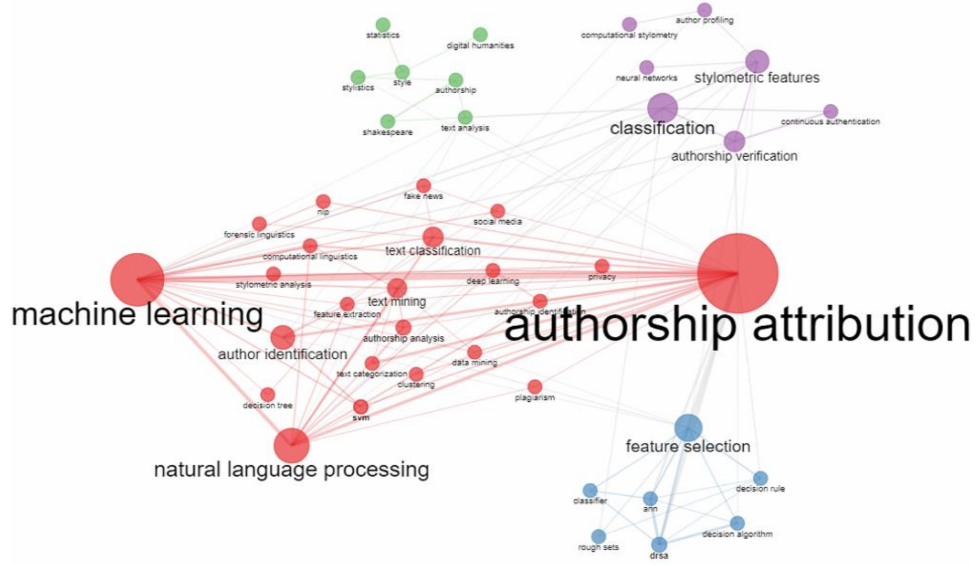
Figure 8. Co-occurrence network (this network was generated by